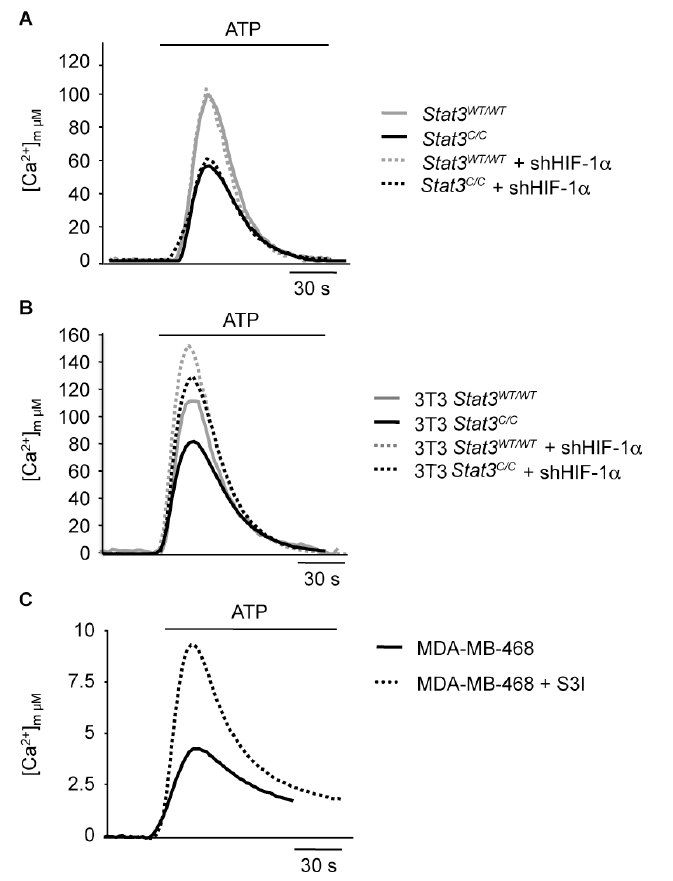
Figure 3. Decreased mitochondrial activity of primary ( A ) or immortalized ( B ) Stat3 C/C MEFs, and of MDA-MB-468 tumor cells ( C ). MEFs of the indicated genotypes, either silenced or not for Hif -1 α , were transduced with a mitochondrial-targeted aequorin (AEQ) [55]. Aequorin activity was measured upon challenging with 100 μ M ATP as indicated. Mitochondrial Ca 2+ response was assessed in MDA-MB-468 cells treated or not with S3I for 12 h ( C ). Data are representative of at least 10 traces, each from three independent experiments. Modified from references [22,24], according to the journals’ license